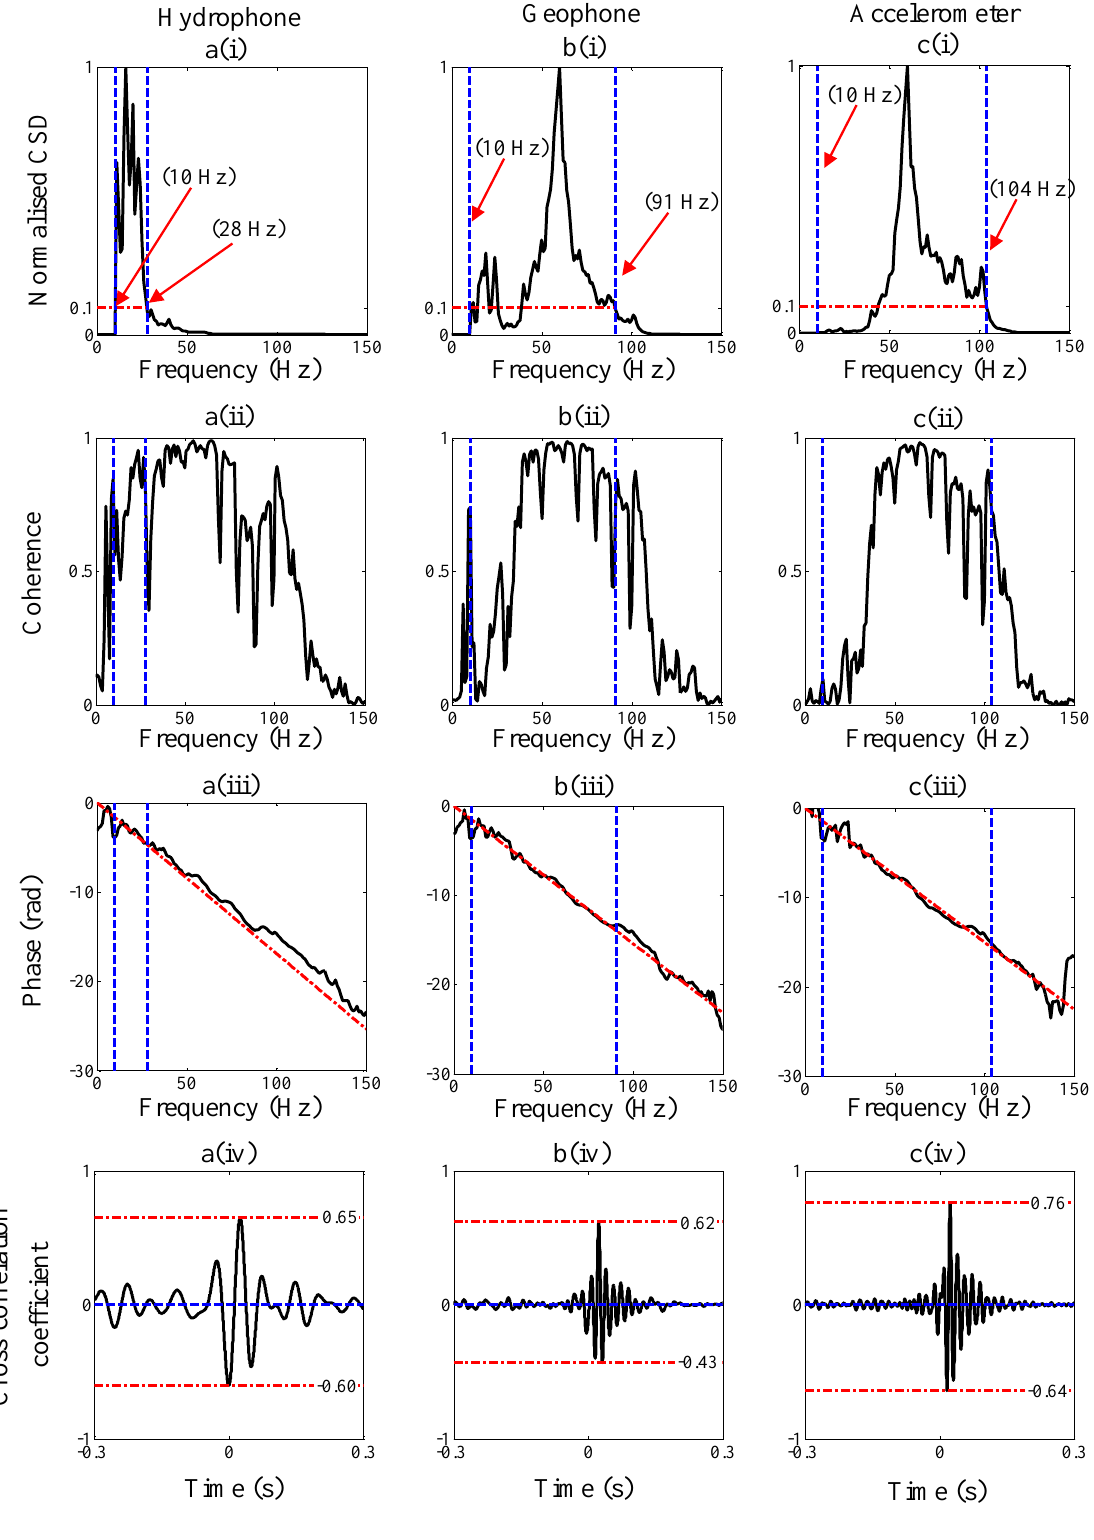
Figure 5. Analysis of the strong leak data from the test-rig. ( a ) Hydrophone; ( b ) Geophone; ( c ) Accelerometer. (i), Normalized CSD with respect to the maximum amplitude between 10 Hz and 150 Hz. (ii) Coherence. (iii) Phase. (iv) Cross correlation